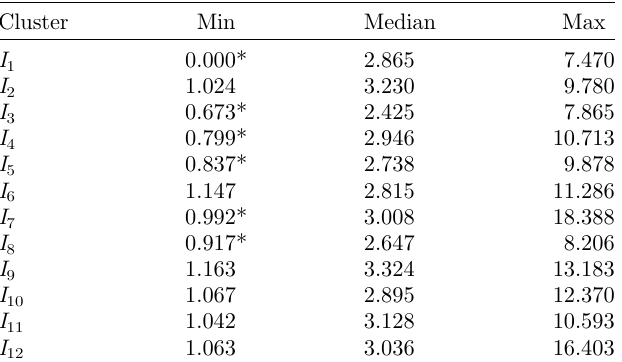
Table 8. By line (for i = 1, . .. , k I ) for each cluster I i is reported the minimum, median and maximum value of d max computed between I i and each group O j , j = 1, ... , k O , see equation (4) and Remark 2. With * we indicate when similarity was detected, for some O j .